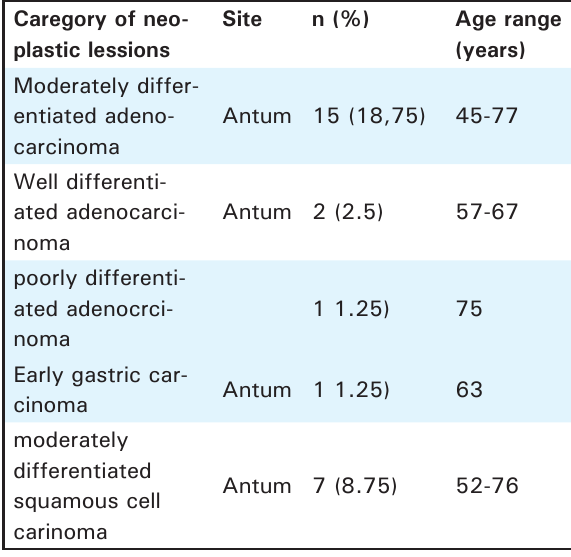
Table 2. Distribution of cases on the basis of